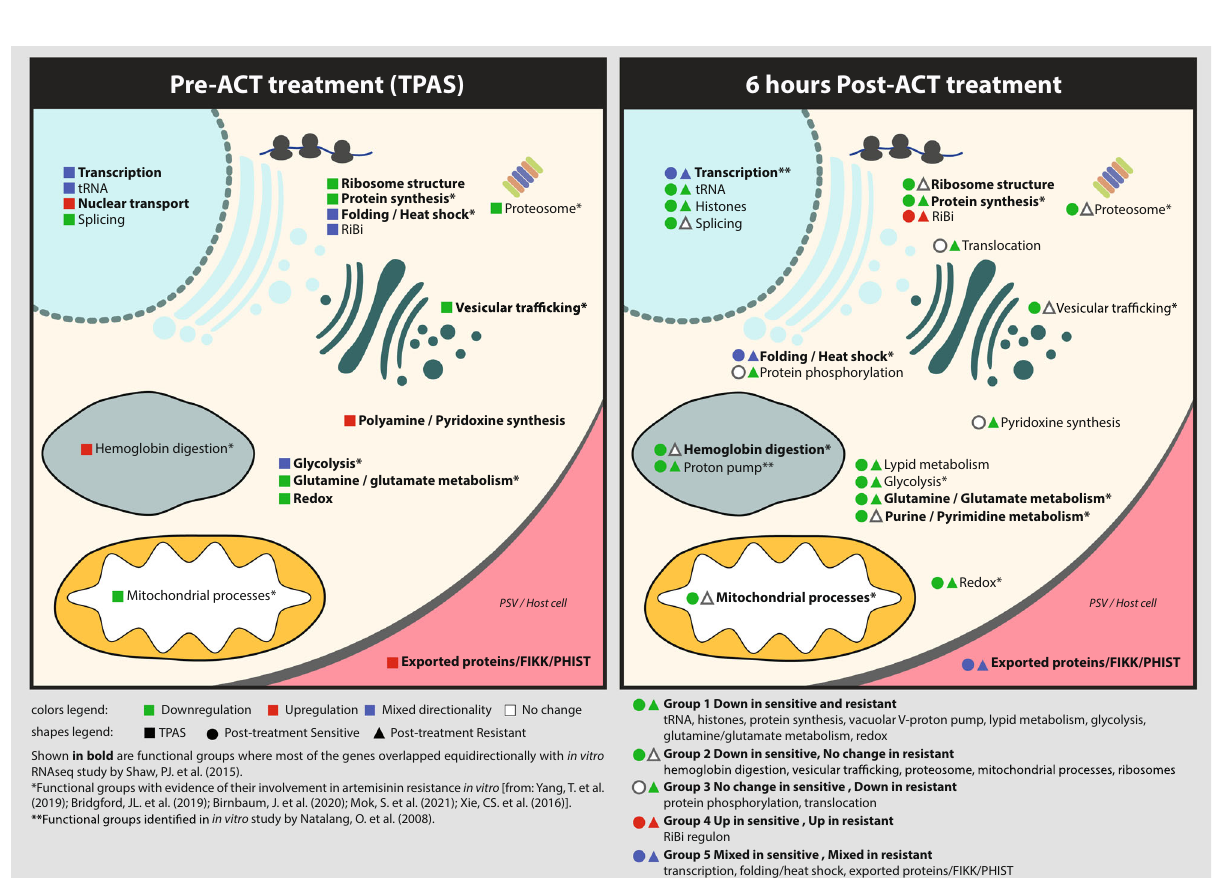
Fig. 4 Functional assignment of resistance markers. Functional assignments of transcriptional artemisinin resistance markers derived from TPAS analysis at baseline-level ( (bl) 0 h) and that of genes repressed/induced after 6 h of ACT treatment ( (tr) 6 h). Colours represent transcriptome directionality for each group. The association with previous independent in vitro studies is also